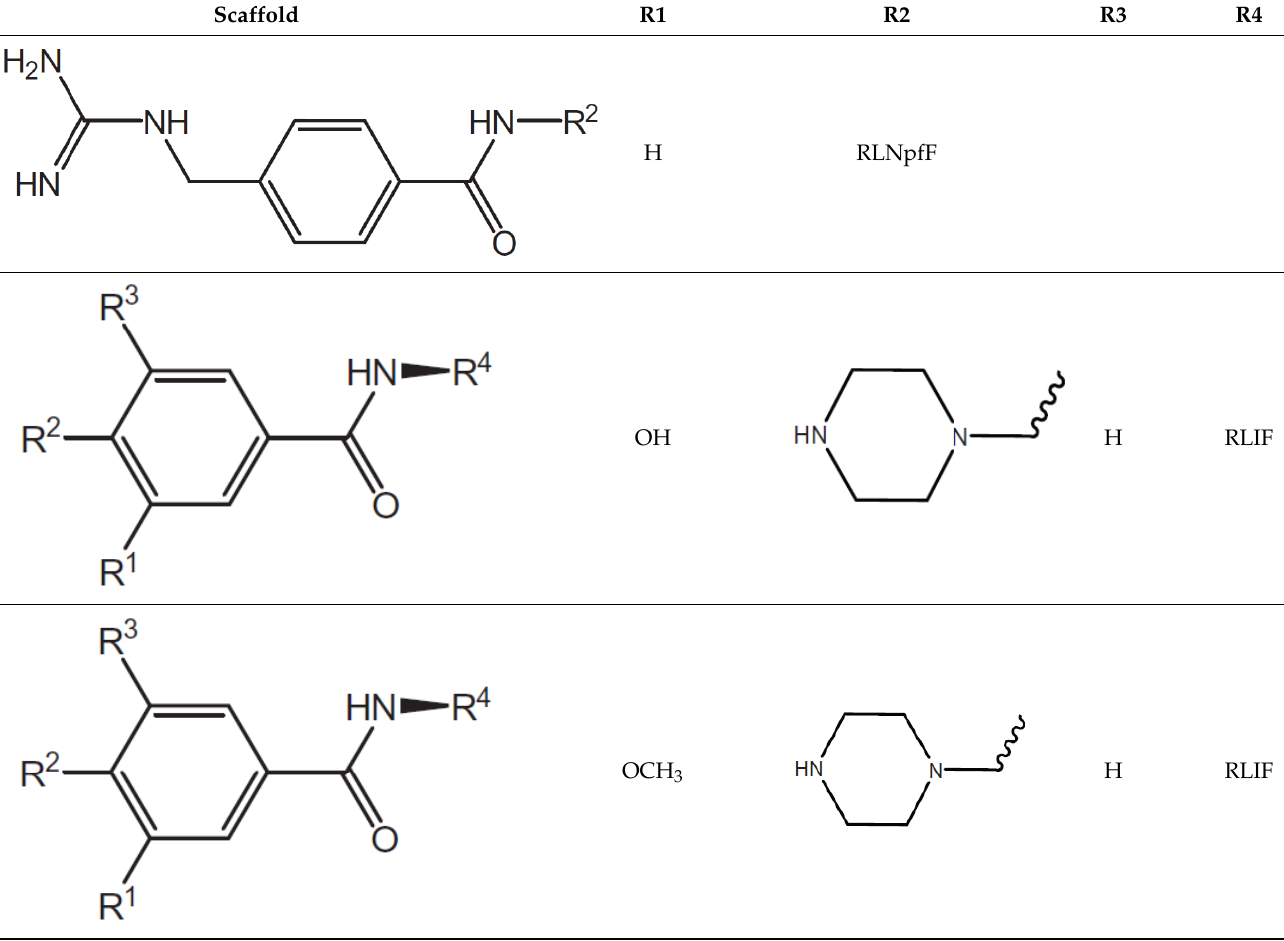
Table 2. Examples of key CDK2/Cyclin A inhibitor lead compounds. From [16] with permission. Scaffold R1 R2 R3